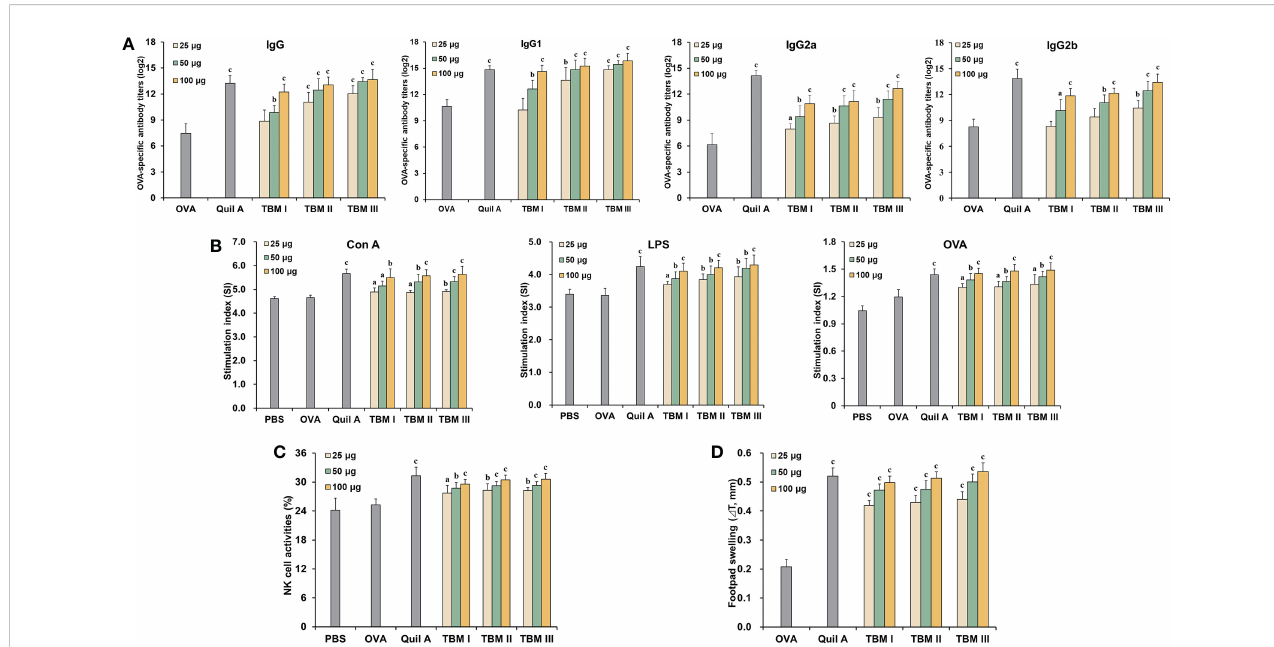
FIGURE 2 Tubeimosides potentiated humoral and cellular immune responses to OVA in mice. The serum and spleen were collected 2 weeks after the booster immunization. (A) Serum OVA-speci fi c antibody titers by ELISA. (B) Splenocyte proliferation by the MTT method (C) NK cell activities by the MTT method. (D) DTH in the OVA-sensitized ICR mice. The data were presented as mean ± SD ( n = 5). a P < 0.05, b P < 0.01, and c P < 0.001 vs